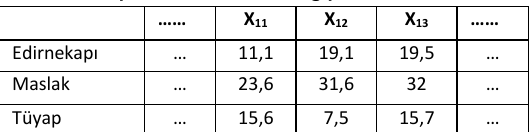
Table 2 : Example of distances matrix (European Side: Depots – routes starting point)